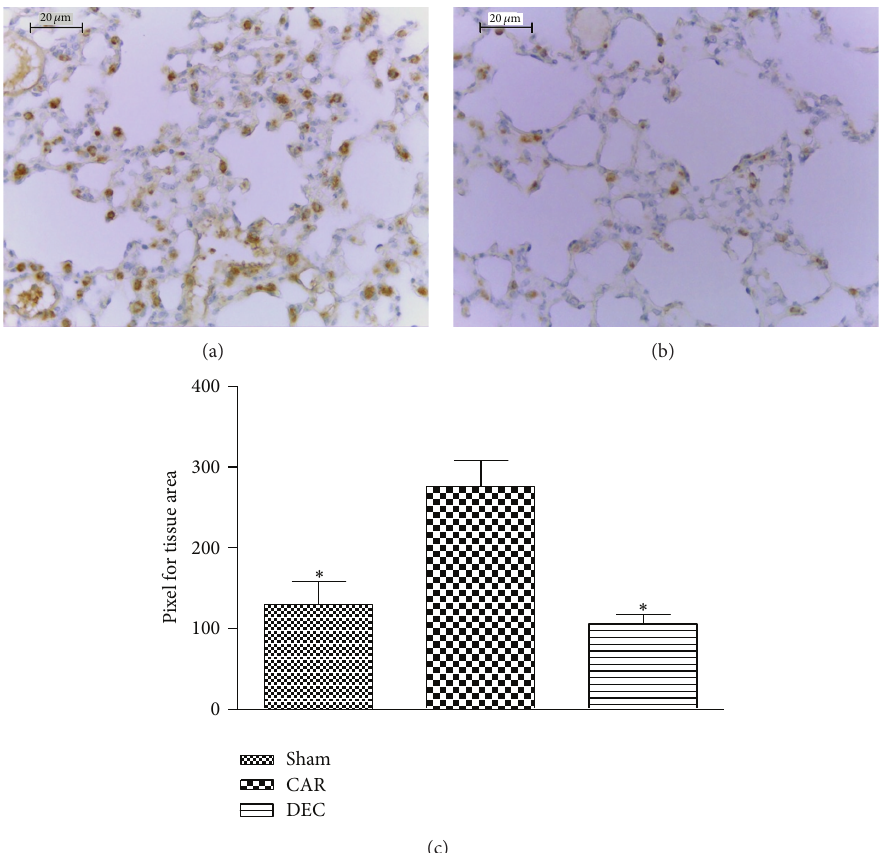
Figure 7: Effect of DEC on immunohistochemical localization of COX-2 in lung tissue after pleurisy induced by carrageenan. (a) In tissue sections from the CAR group, positive labeling was detected on type II pneumocytes. (b) Treatment with DEC significantly reduced COX-2 staining in comparison to the CAR group, achieving levels similar to the sham group. (c) Densitometry analysis of immunohistochemistry photographs for COX-2 from lung tissues; figure is representative of at least 3 experiments performed on different experimental days; data expressed as mean ± S.E.M. from 𝑛 = 5 mice for each group; ND: not detected; ∗ 𝑃 < 0.05 versus carrageenan; scale bar = 20 𝜇